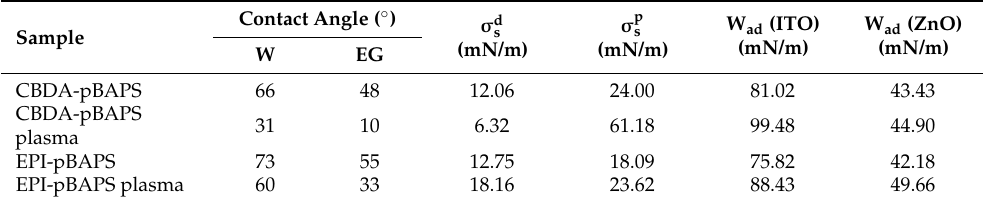
Table 5 lists the experimental data on contact angles on the CBDA-pBAPS and EPI- pBAPS films, before and after plasma irradiation. Table 5. The results regarding the contact angles, dispersive and polar surface tensions of the PIs and their work of adhesion with ITO or